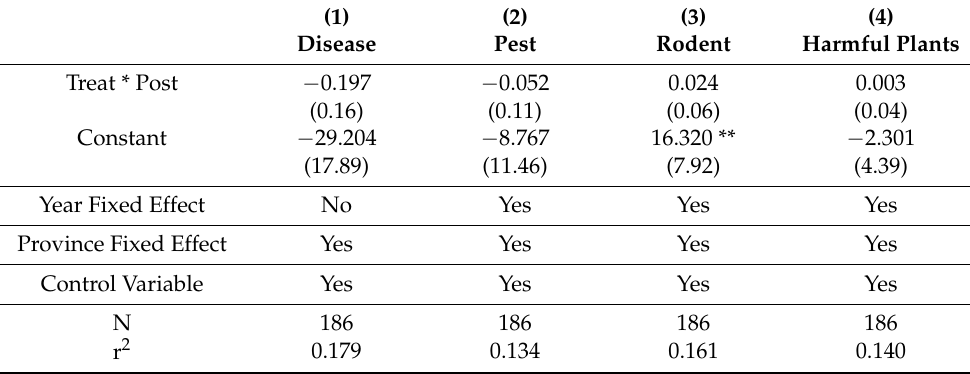
Table 9. Fixed-effects regression model results: classification of forest pests.